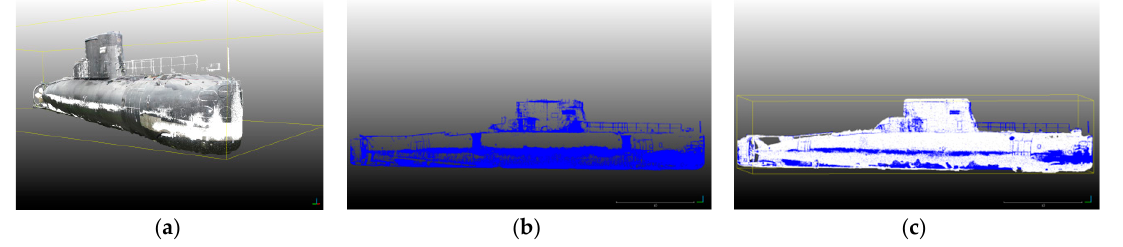
Figure 11 . (a ) Photogrammetry RGB point cloud and laser, ( b ) laser scanning point cloud, and ( c ) merged TLS (blue) and photogrammetry (white) point clouds .